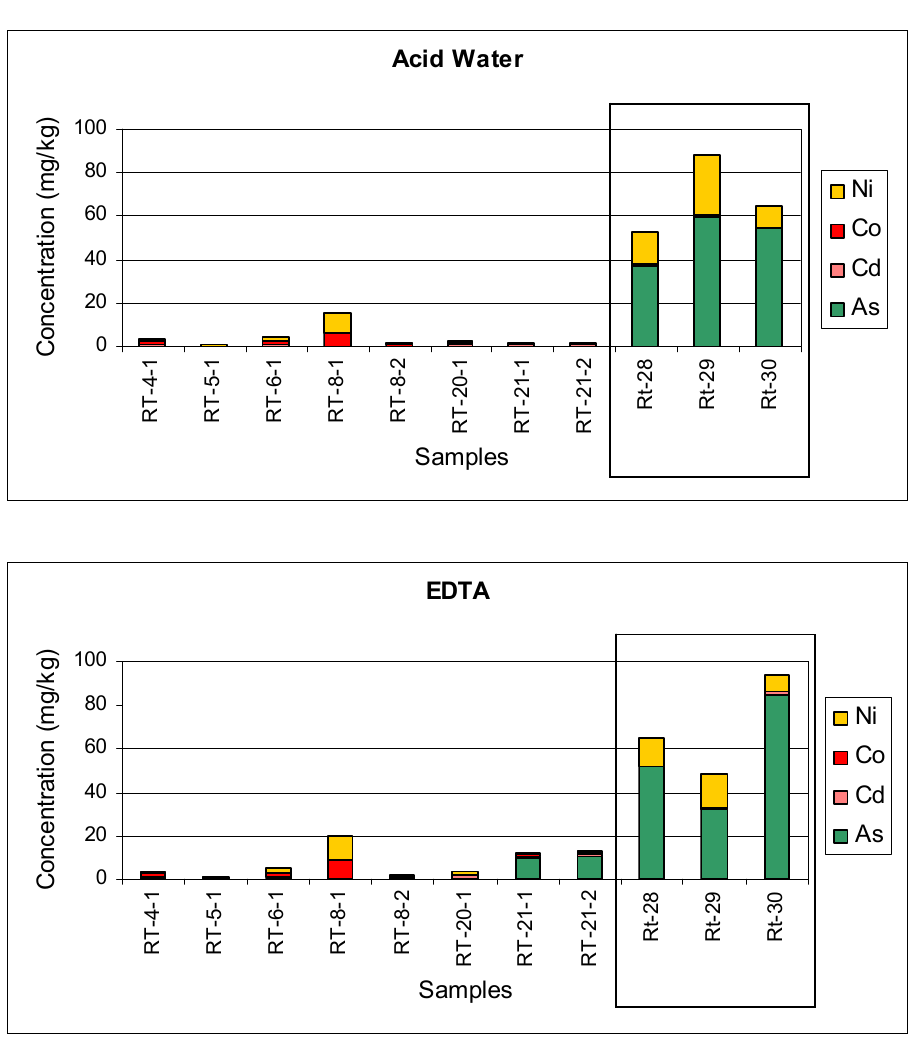
Figure 5. Acid water and EDTA extractions in selected samples without results for Fe, Mn, Pb, Zn and Cu. Samples directly affected by mining wastes or leachates are